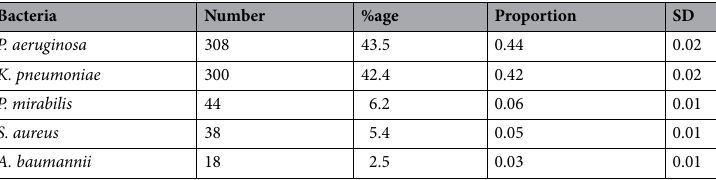
Table 1. Frequency of bacteria isolated from burn wound patients (N = 708). A. baumannii , Acinetobacter baumannii ; P. mirabilis , Proteus mirabilis ; SD, standard deviation.